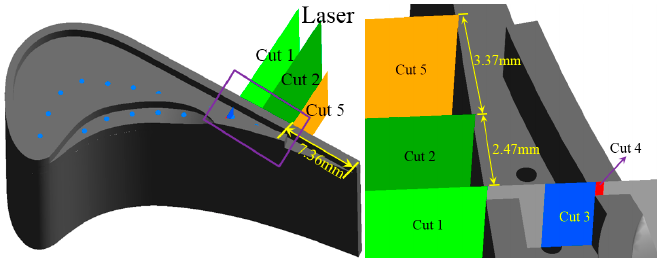
Figure 2. Blade model geometry illustration, and locations of PIV capture and simulation. Table 1. Tested blade parameters (scaled up by three times) and experimental conditions.